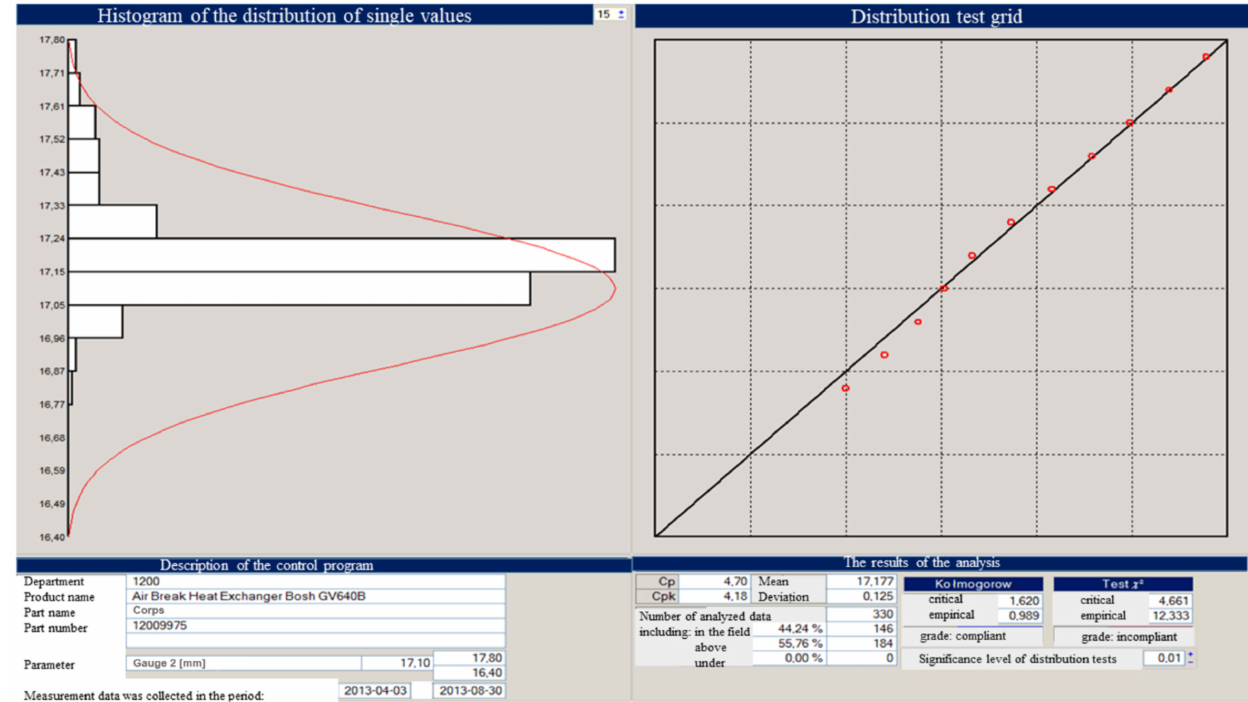
Figure 28. Histogram showing an anomaly in the process.